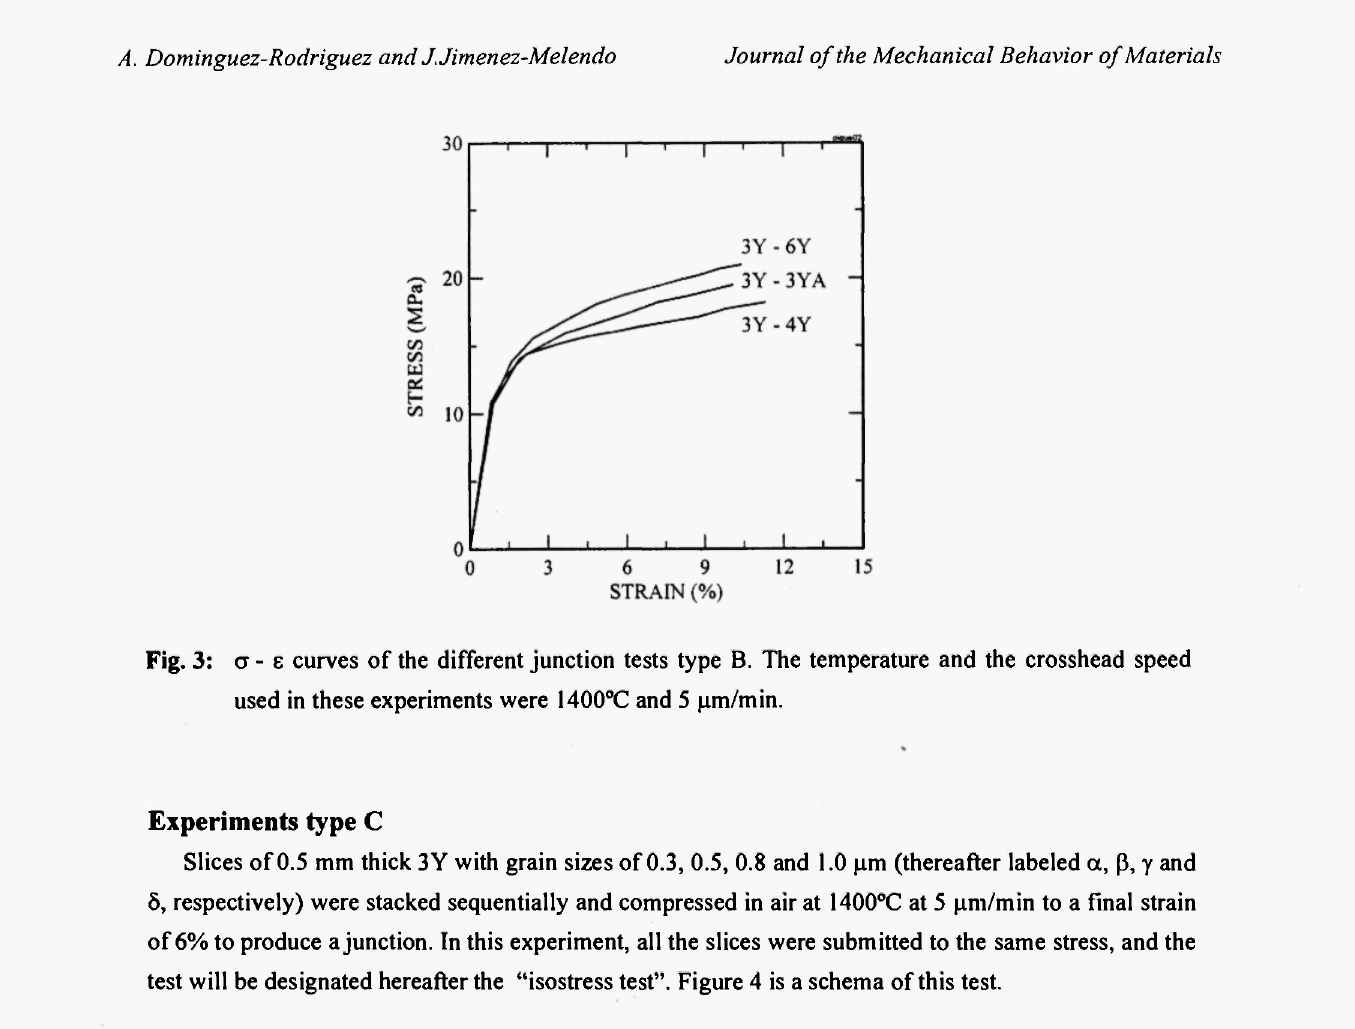
Fig. 3: σ - ε curves of the different junction tests type B. The temperature and the crosshead speed used in these experiments were 1400°C and 5 μπι/min.